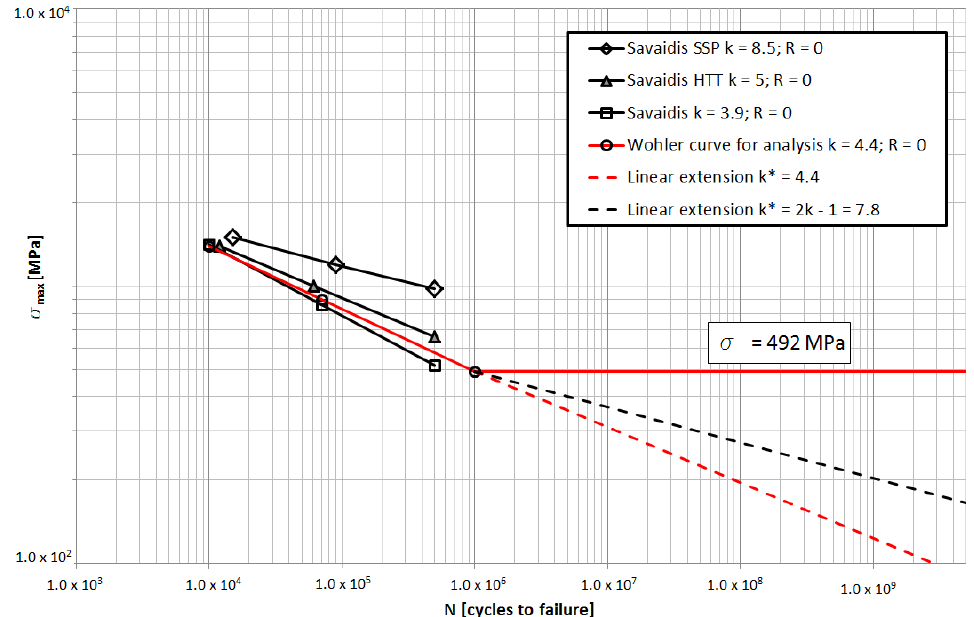
Figure 11. Fatigue curves of 51 CrV4 steel for R = 0 and the characteristic (red) adopted based on the performed tests.